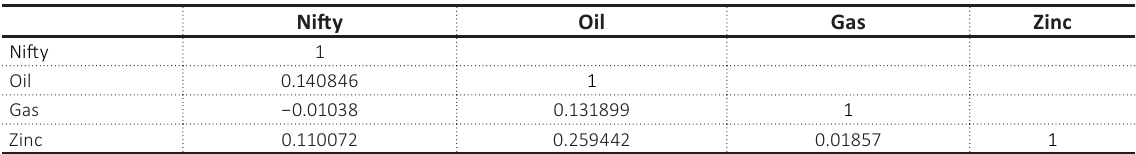
Table 4. EVT parameter estimates of the Nifty index and commodity futures